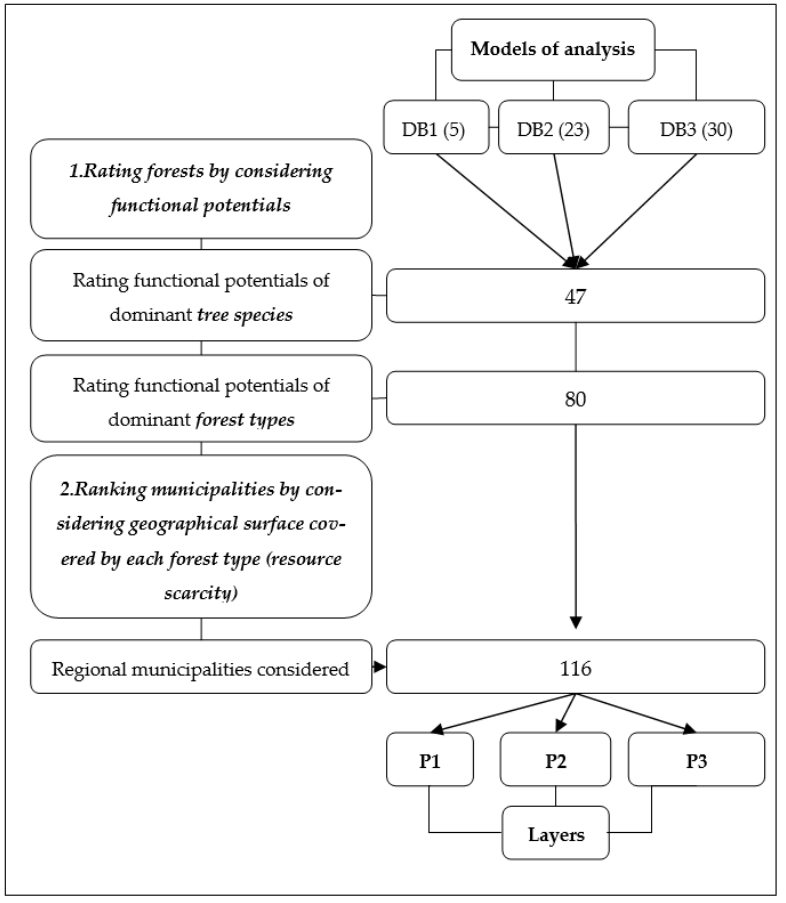
Figure 3. Rating tree species for potential respiratory benefits purposes. Source: authors.